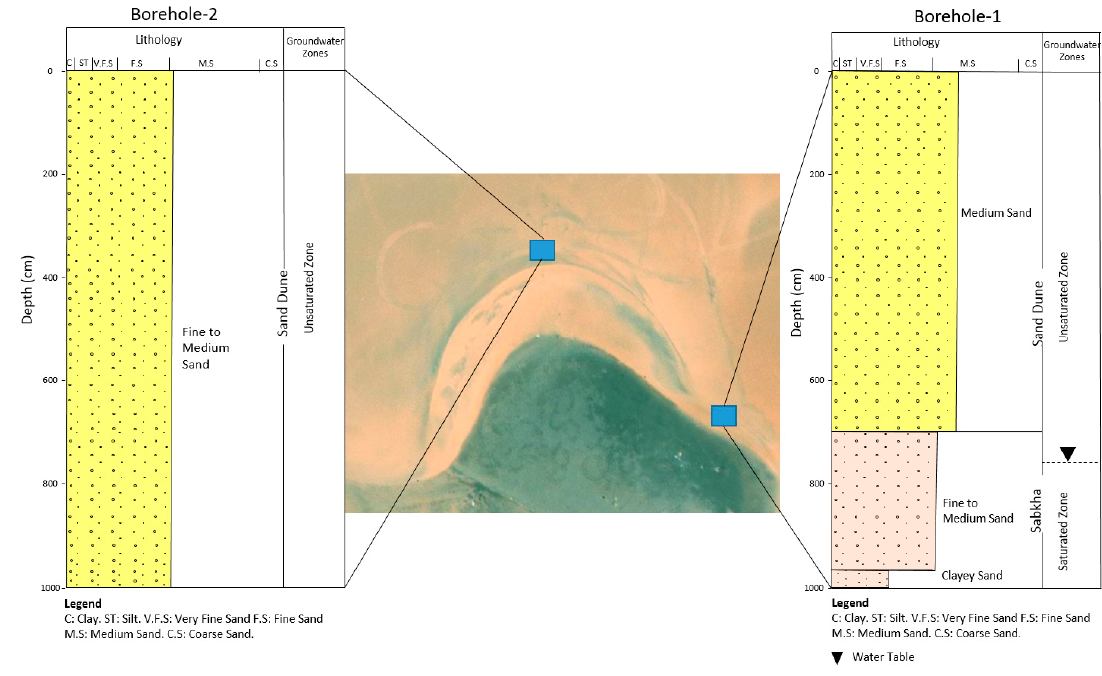
Figure 3. Lithology logs of the two boreholes showing the sand type and groundwater zones.